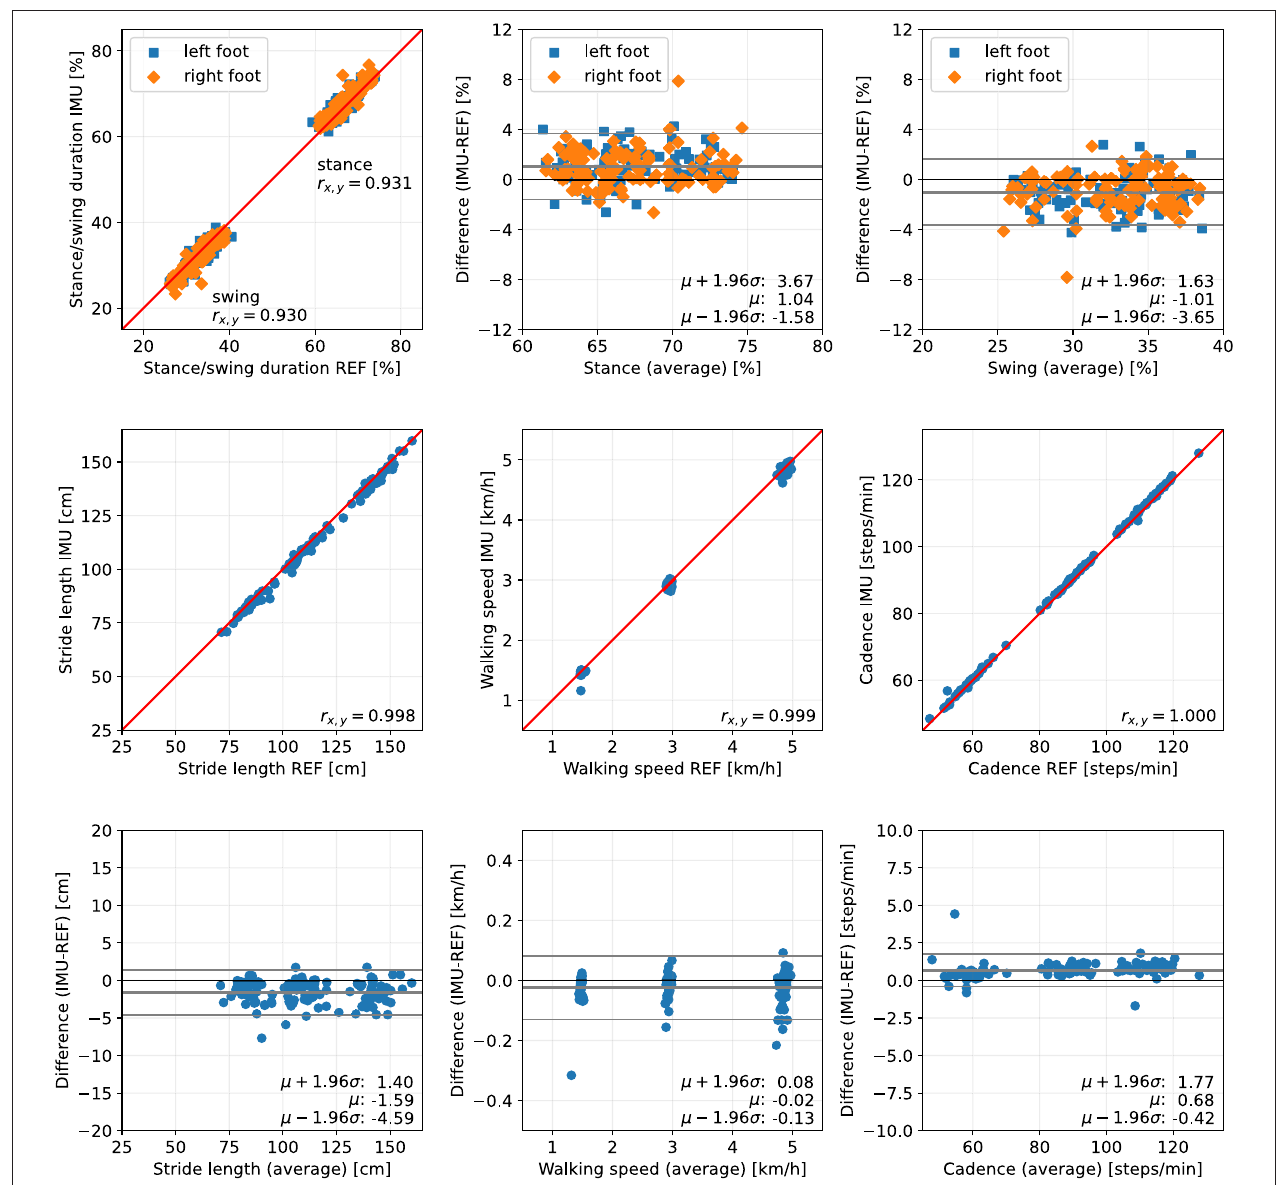
FIGURE 10 | Scatter plots and Bland-Altman plots for stance and swing duration, stride length, walking speed, and cadence of 39 healthy subjects walking at 1.5, 3, and 5 km/h. Red: 45-degree lines ( y = x ). Values obtained with the proposed IMU-based methods (IMU) are compared to the ground truth from the Zebris reference system (REF). The average deviation is ∼ 1% for gait phase durations, below 2cm for the stride length, below 0.05km/h for the walking speed, and below 1step/min for the